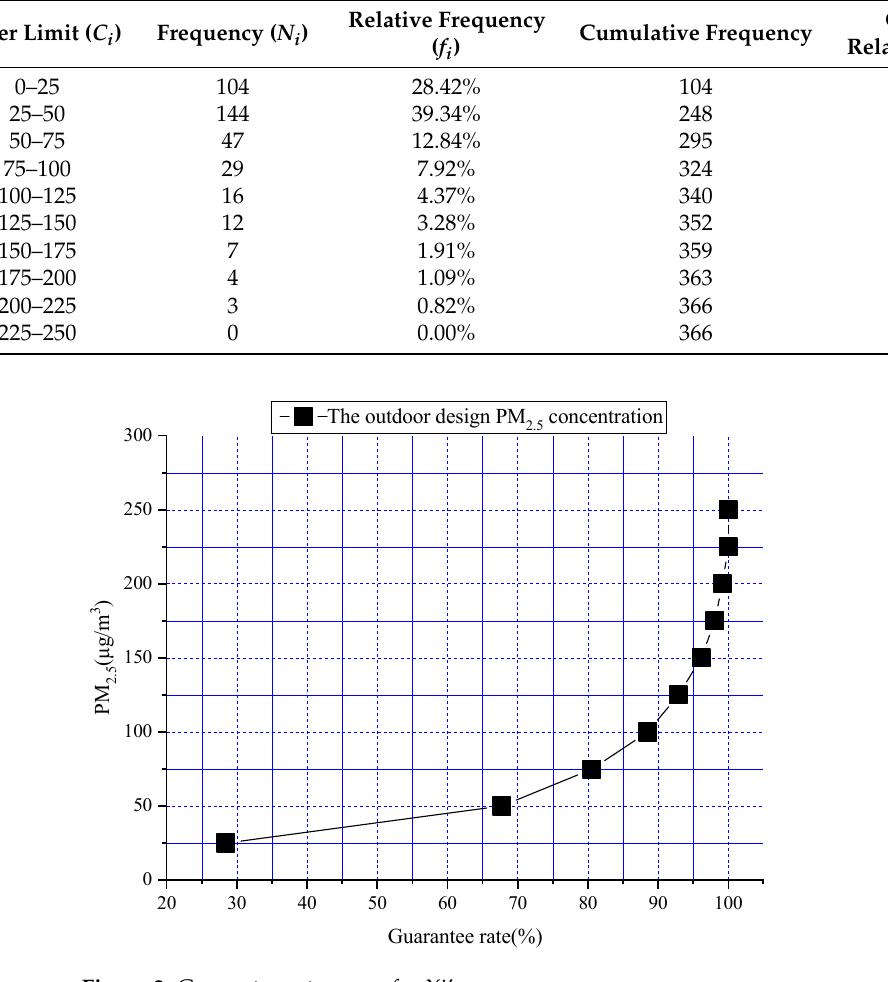
Figure 3. Guarantee rate curve for Xi’an.